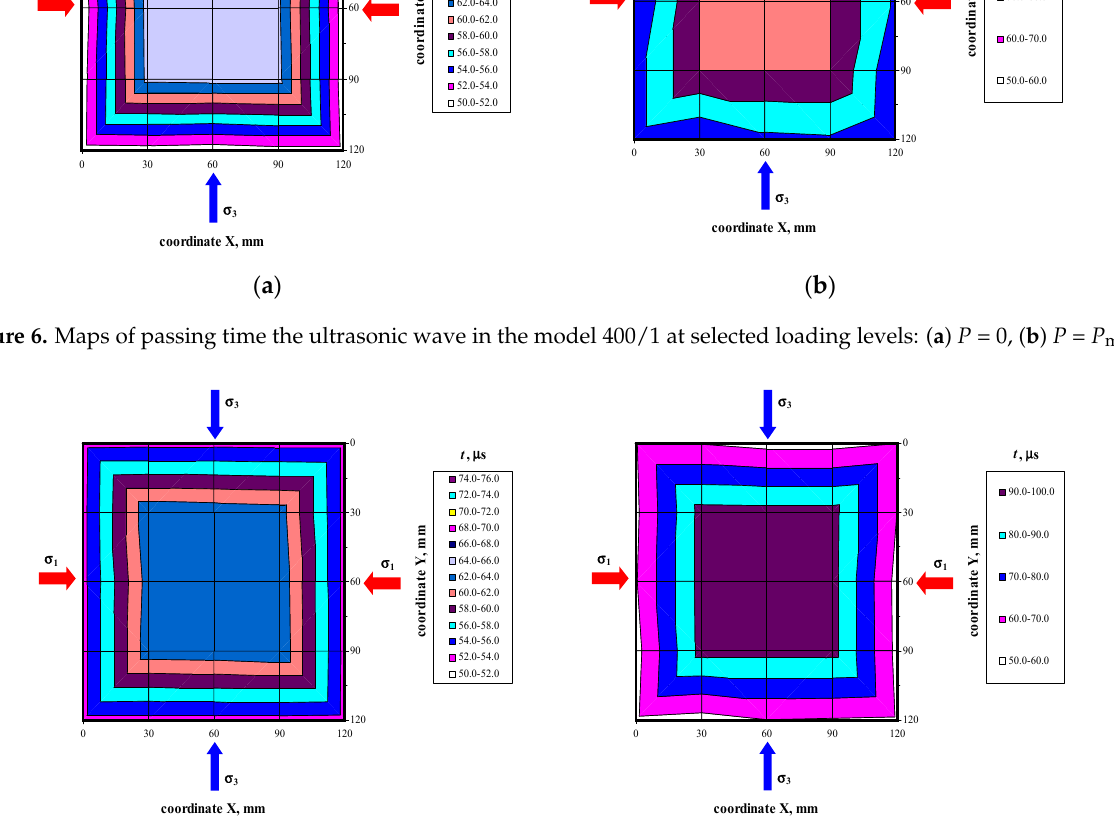
Figure 7. Maps of passing time the ultrasonic wave in the model 500/1 at selected loading levels: ( a ) P = 0, ( b ) P = P max.